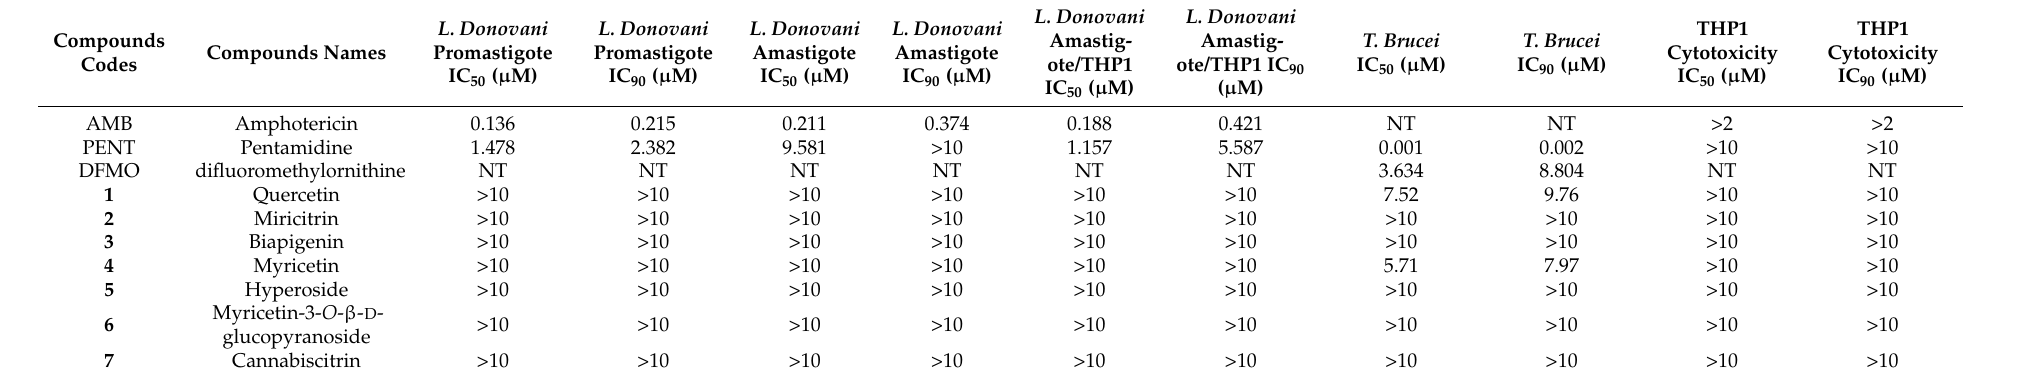
Table 1. Antiprotozoal activity and cytotoxicity of isolated compounds of H. afrum.